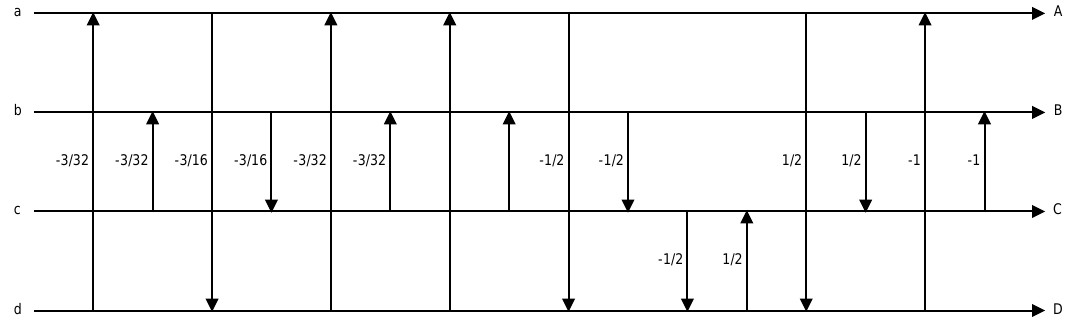
Figure 17. Implementation of 4 × 1 POT.